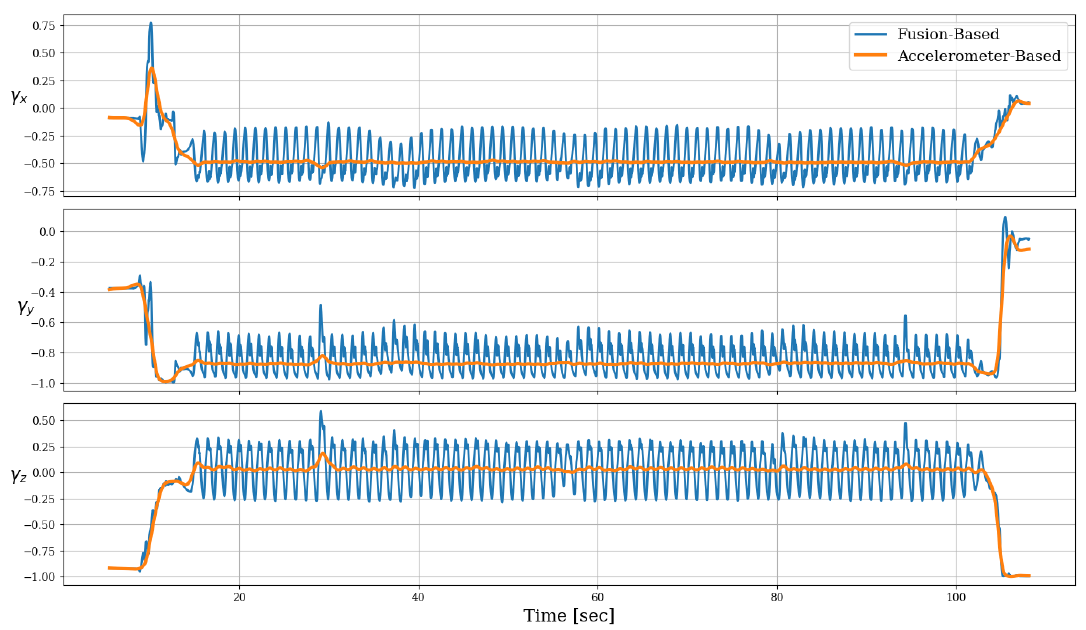
Figure 2. Estimated gravity direction along time, comparing the accelerometer-based method with the gyroscope-accelerometer fusion